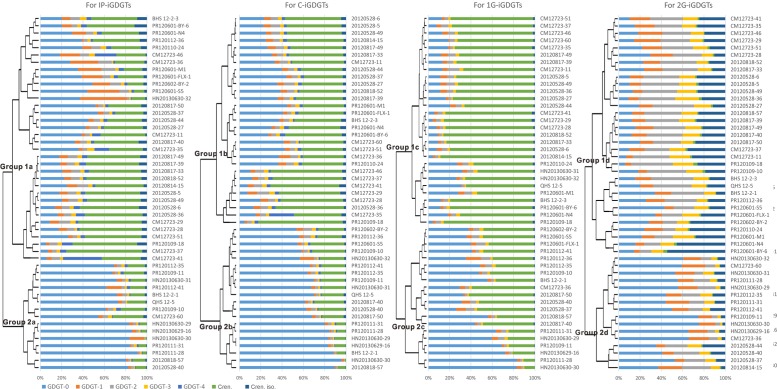
Cluster analysis on the IP-, C-, 1G-, and 2G-iGDGT distributions.